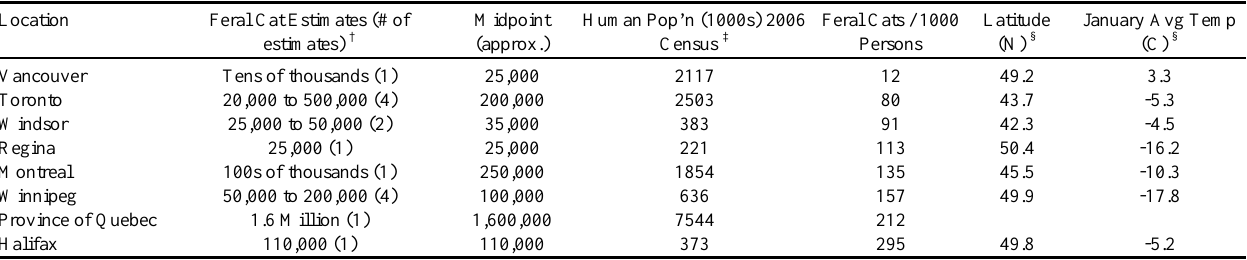
Table 2 . Feral cat estimates in Canada from media reports, in relation to 2006 human population, latitude, and January temperature. Location Feral Cat Estimates (# of Midpoint estimates) †